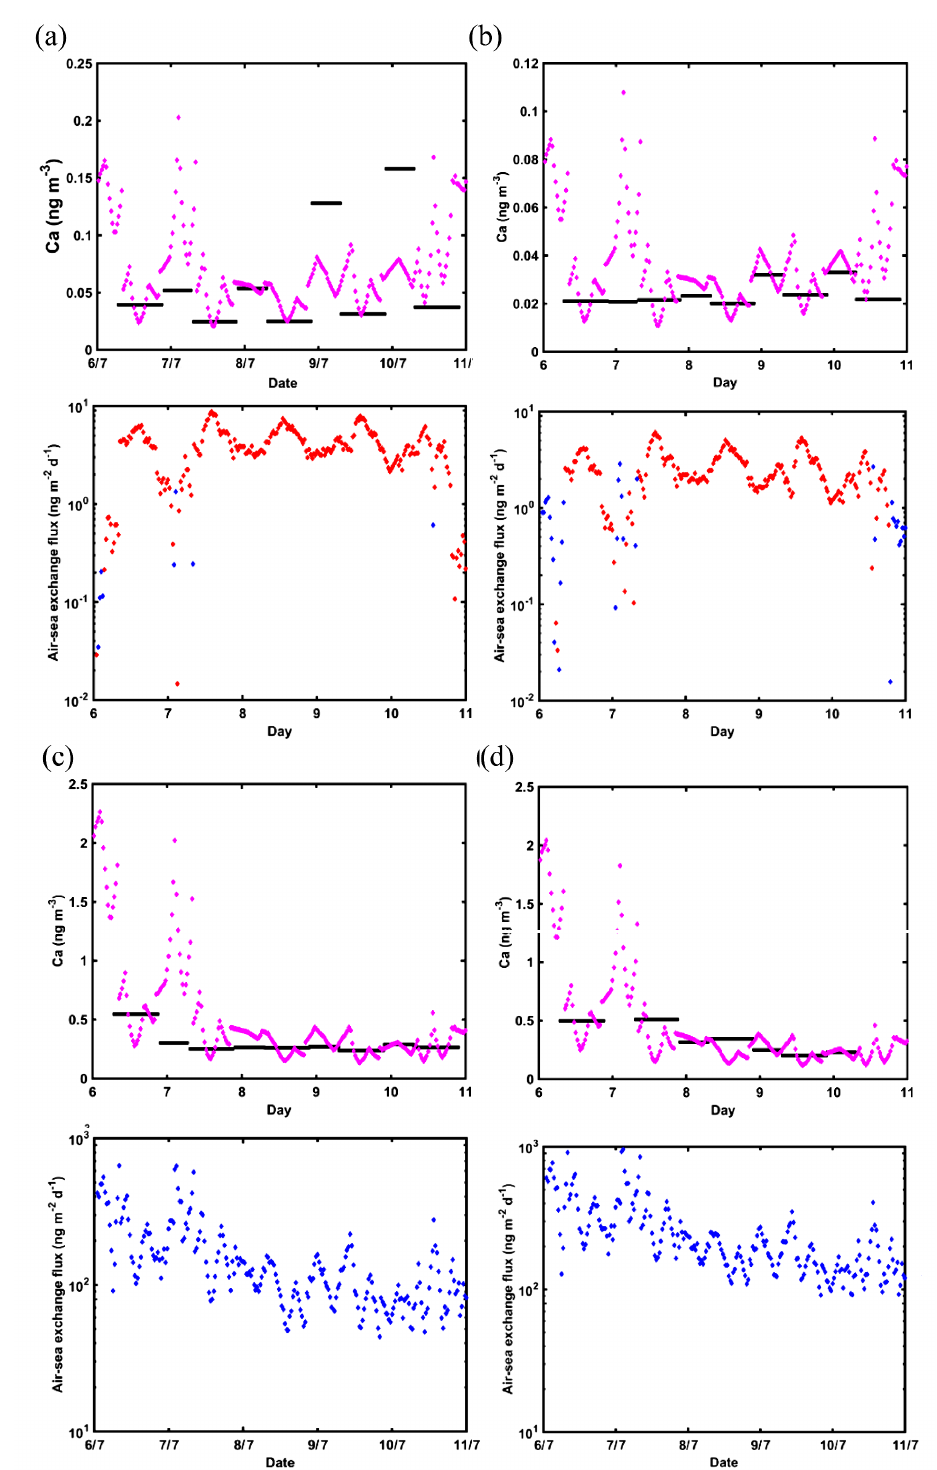
Figure 2. Predicted (pink) and observed (black) concentrations (ngm − 3 ) and predicted diffusive air–sea exchange fluxes, F c , (lower: red upward and blue downward, ngm − 2 day − 1 ) of selected contaminants, (a) HCB, (b) PCB28, (c) FLT and (d) BDE47 during 6–10 July